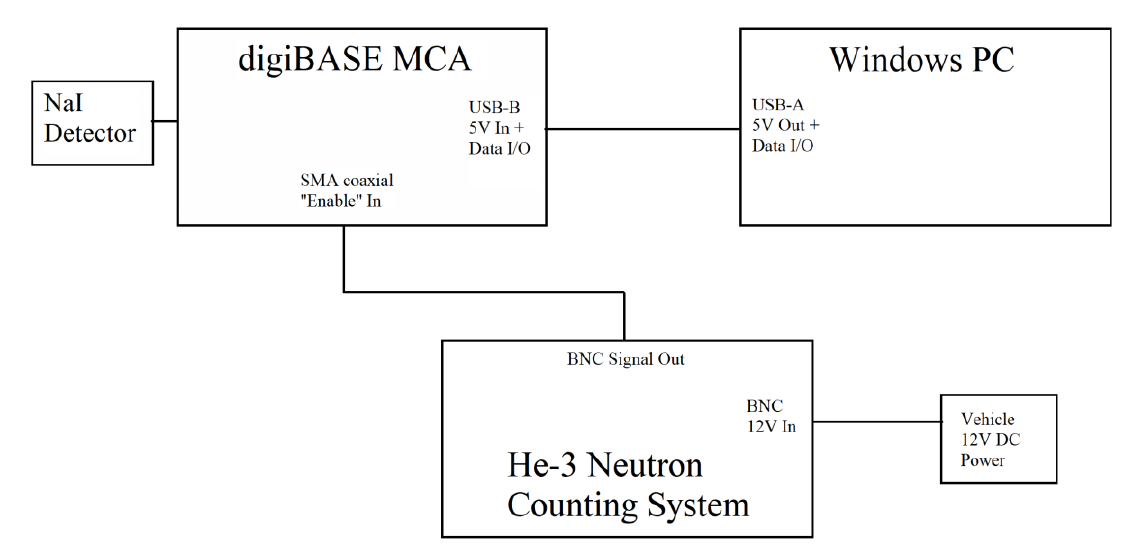
Figure 1. Block diagram outlining the connections when operating the Ortec NAI-SS-4-P system